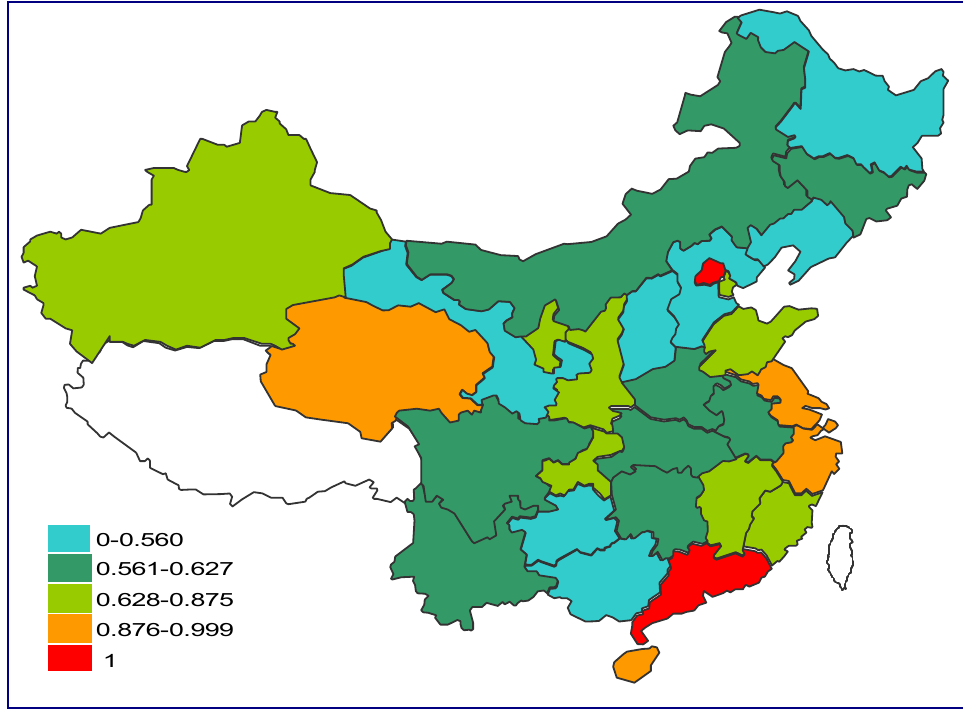
Figure 5. Distribution of the mean value of the revised carbon emission efficiency results by province in China, 2006–2019.